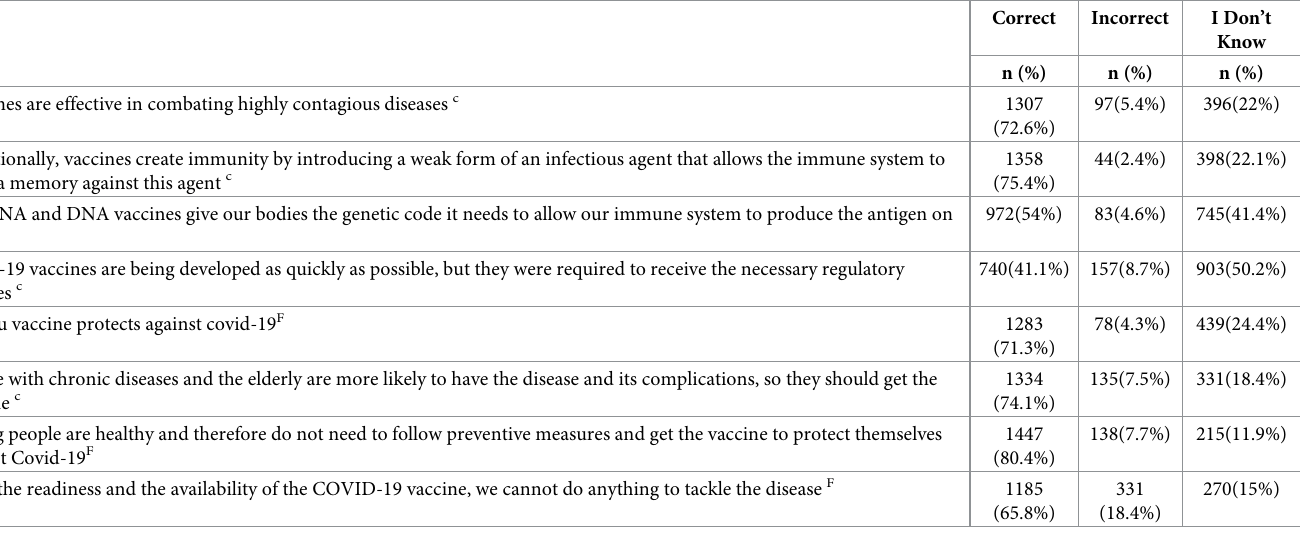
Table 4 summarized the multivariable logistic regression of the factors associated with the will- ingness to receive the COVID-19 vaccine. HCWs who were male (aOR = 1.99, 95% CI (1.41– Table 3. Knowledge items related to the COVID-19